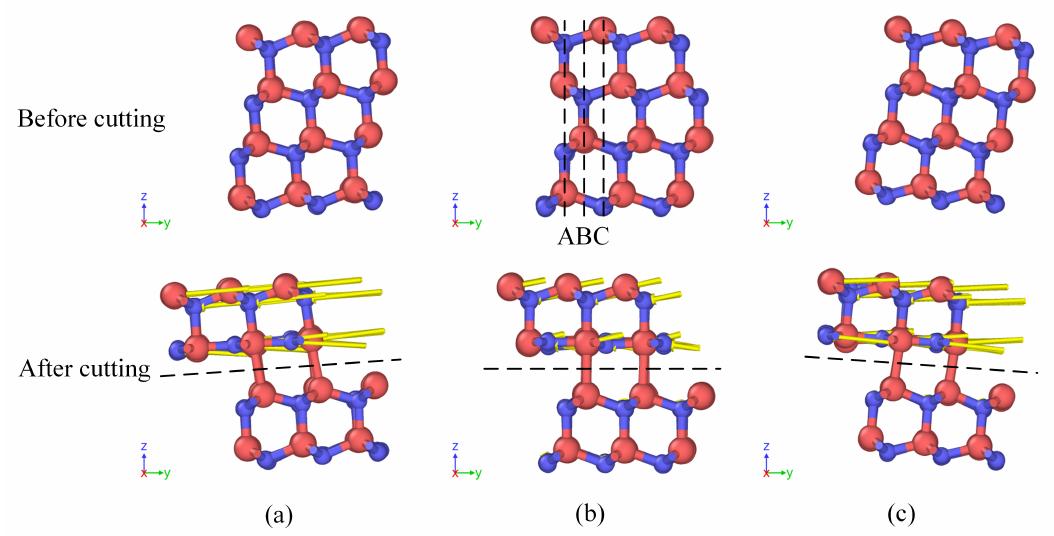
Figure 5. Structure transformation in the defect region after cutting: ( a ) 4 ◦ off-axis toward [1 − 100]; ( b ) on-axis; ( c ) 4 ◦ off-axis toward [ −